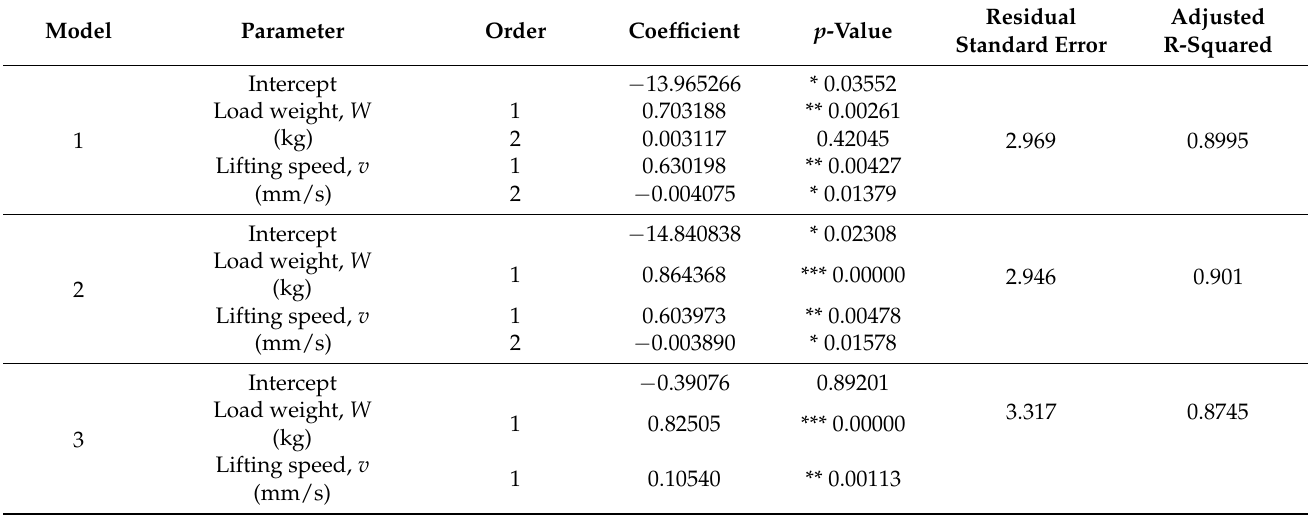
Table 4. 1RM equations and model